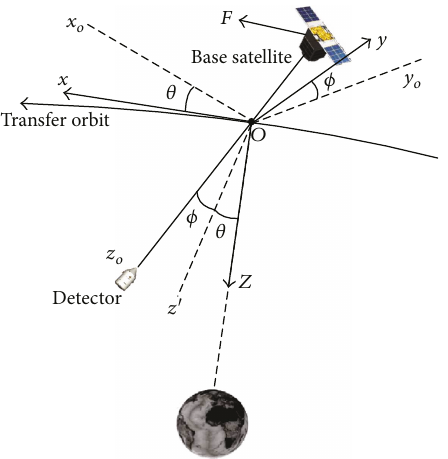
Figure 1: Description of a dumbbell-modeled tethered system.